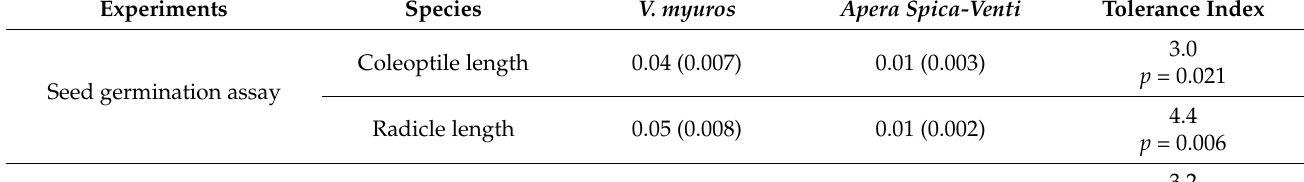
Table 3. Mesosulfuron-methyl + iodosulfuron-methyl-sodium rates (mg/L) providing 50% reduction of response variable using log-logistic model for V. myuros and A. spica-venti in agar-based seed germination and seedling assay. Standard errors are presented in parentheses.